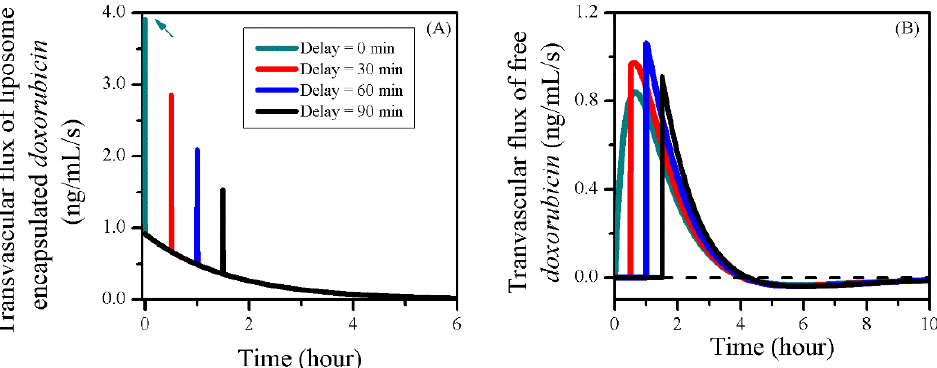
Figure 11. The time courses of drug transvascular flux in the treatments with different BBBD timings. ( A ) Liposome-encapsulated doxorubicin and ( B ) free doxorubicin.